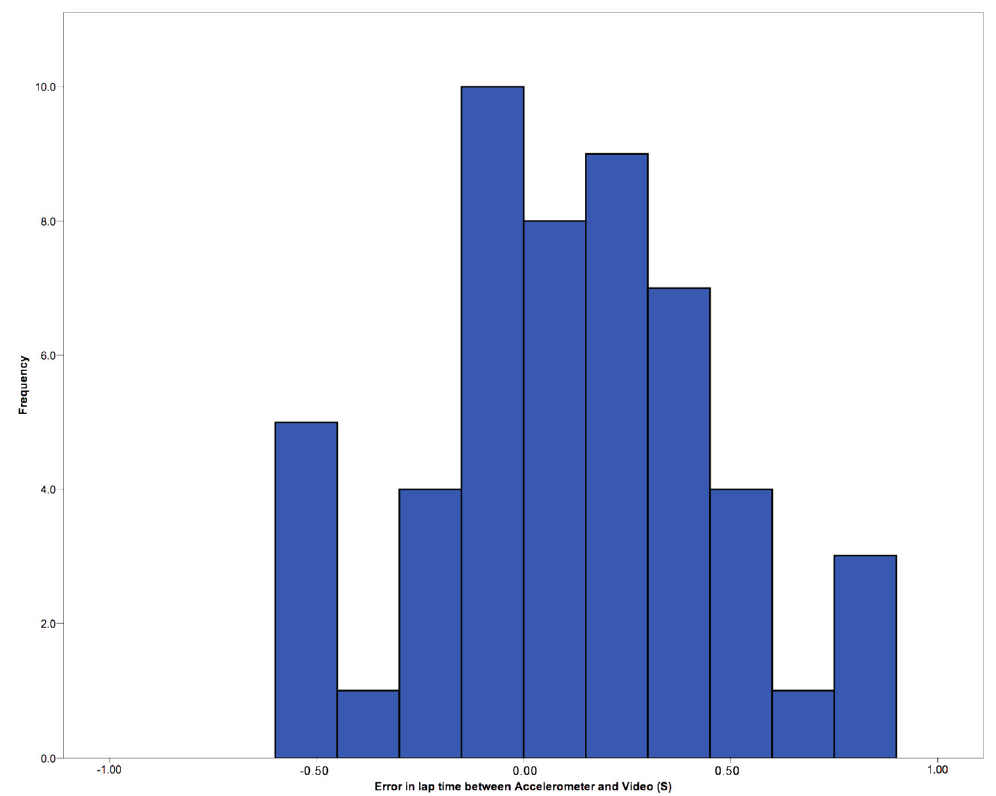
Figure 6. Error in seconds between video and accelerometer manually selected lap